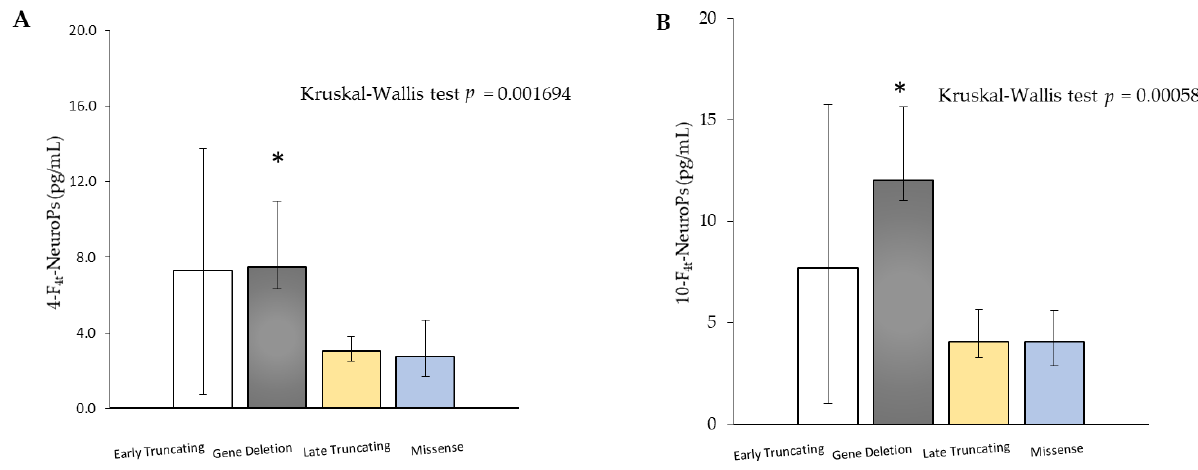
Figure 2. Plasma levels of 4-F 4t -NeuroP ( A ) and 10-F 4t -NeuroP ( B ) in RTT subjects as a function of MECP2 mutation categories. Data are medians (columns) and bars are interquartile ranges (25th–75th percentiles). * Different from early truncating, late truncating, and missense mutations; post hoc analysis, Conover test p < 0.05.